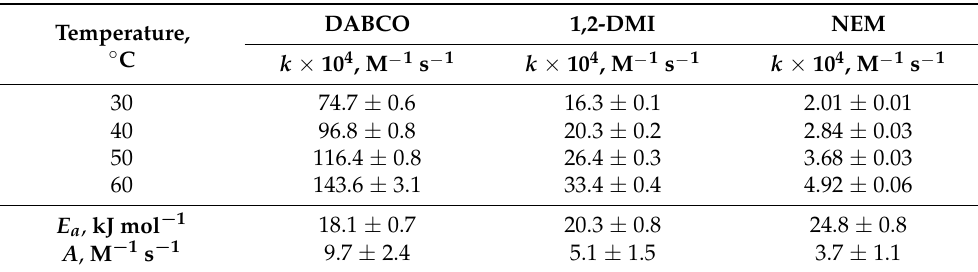
Table 1. Initial reaction rate constants ( k ) for urethane formation in the presence of the stud- ied catalysts, 1,4-diazabicyclo[2.2.2]octane (DABCO), 1,2-dimethylimidazole (1,2-DMI), and N - ethylmorpholine (NEM), at different temperatures, along with the corresponding Arrhenius ac- tivation energies ( E a ) and pre-exponential factors ( A ). The E a and A values were obtained by the method of least